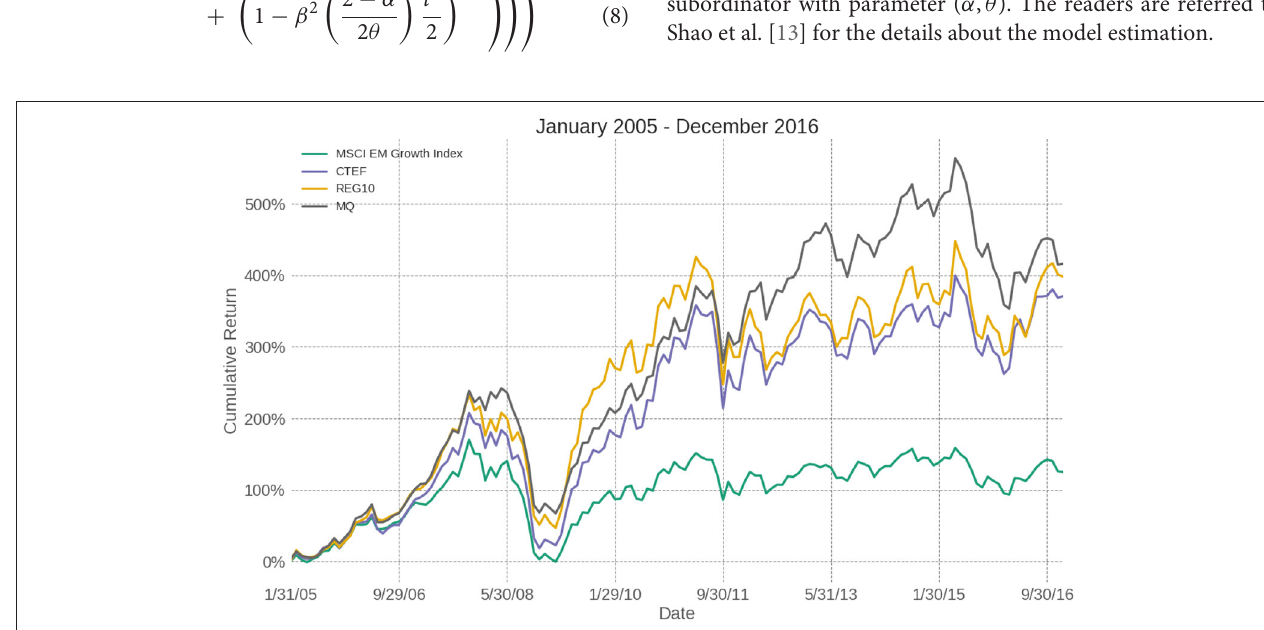
FIGURE 3 | Portfolio performance with EM (Emerging Market) universe.